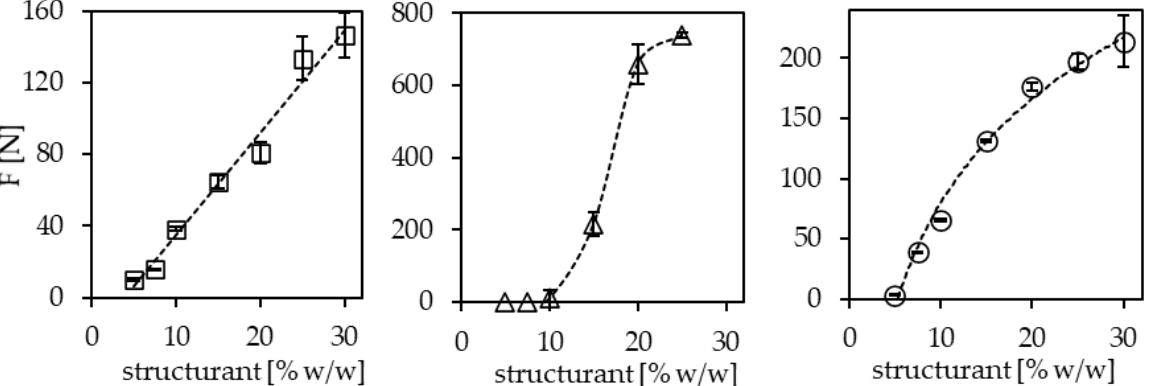
Figure 5. Hardness determined by penetration test as a function of structurant concentration in canola oil: squares: sunflower wax; triangles: 1:1 molar mixture sitosterol/oryzanol; circles: ethylcellulose 100 cP. Samples stored for 7 days at 5 °C; stabilized for 2 h at 22 °C before analysis.